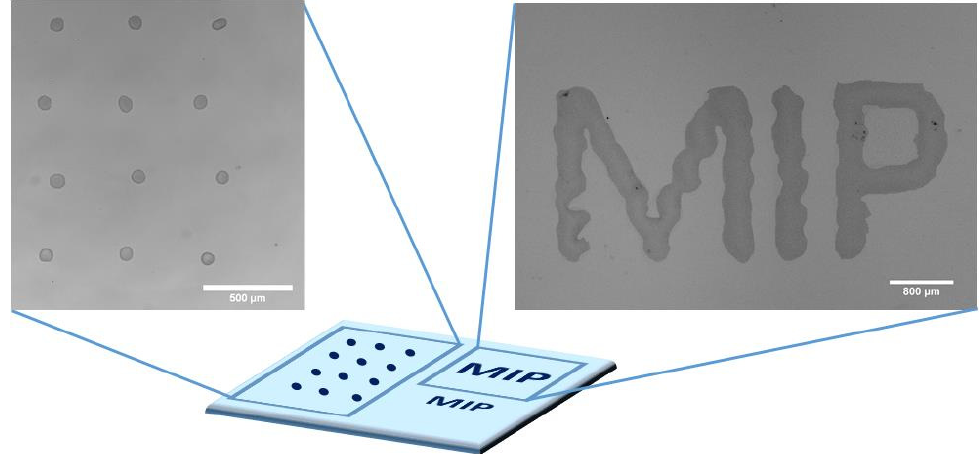
Figure 1. Design of the inkjet-printed MIP microarray with microscopic images of a pattern of 12 droplets, in a zig-zag shape ( left ), and the inkjet-printed letters “MIP” ( right ), both based on TRIM.